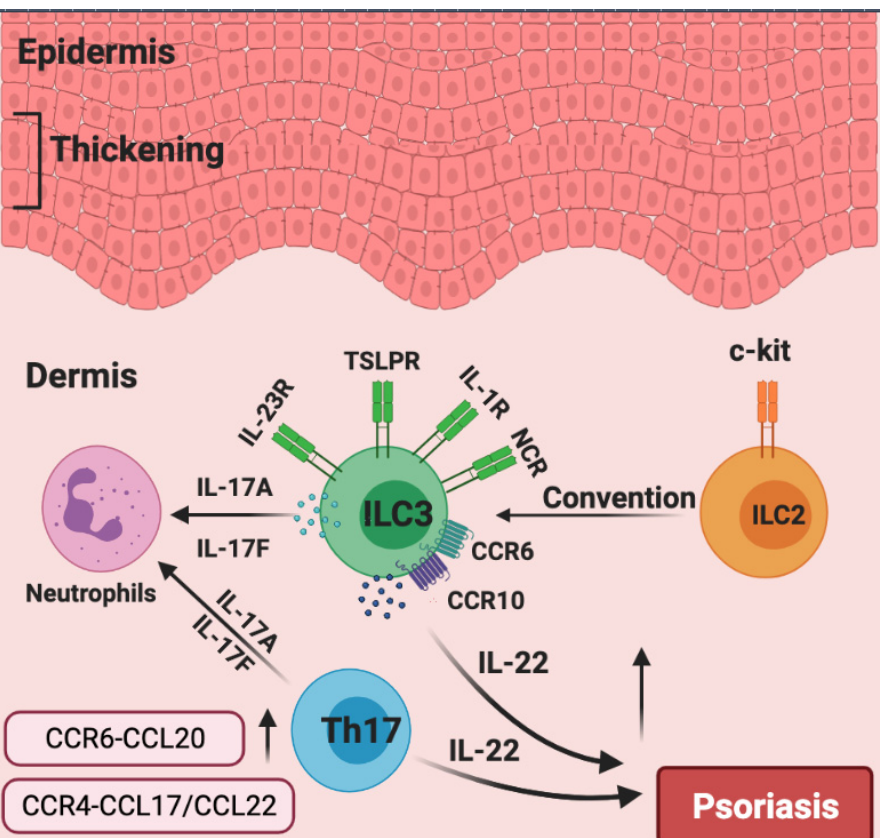
Figure 4. The roles of chemokines and group 3 ILCs in the pathogenesis of psoriasis. Generally, the over-production of IL-22 leads to epidermal thickening in psoriasis. Patients with psoriasis have increased numbers of NCR+ ILC3s. CCR6 and CCR10 are indispensable for the migration of ILC3 to inflamed skin. Skin-invading populations of ILC3s rather than T helper 17 (TH17) cells are the major source of IL-17A and IL-17F, which induce neutrophilic inflammation. c-Kit+ ILC2s could potentially be converted into IL-17A-expressing ILC3s. The production of CCR6–CCL20 and CCR4–CCL17/CCL22 are significantly increased in the psoriasis skin.